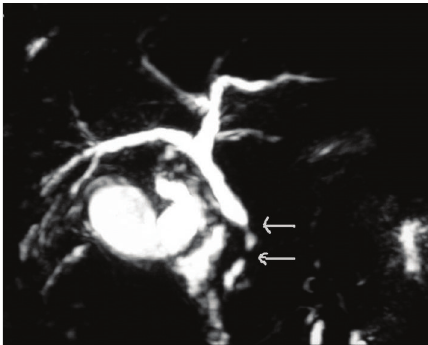
Figure 2: MRI cholangiopancreatography: wall regular thickening of the main bile duct with distal